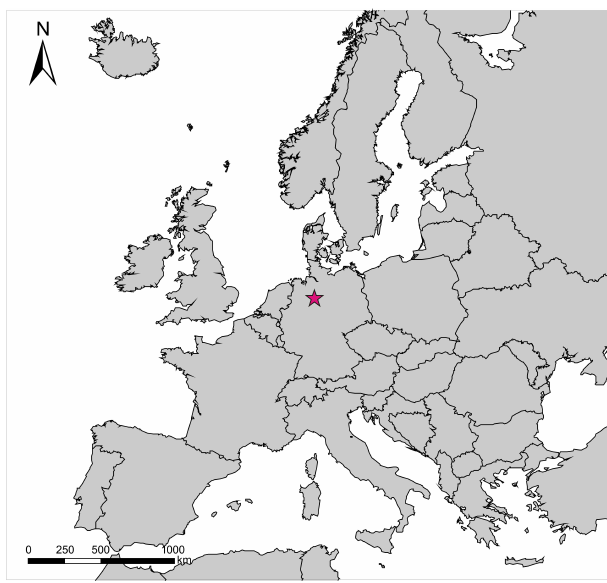
Figure 1. Location of the study site TOMO_south, indicated by a star.